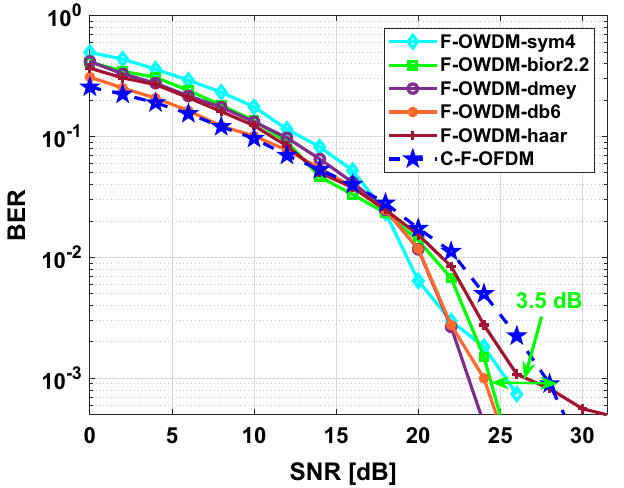
Figure 14. Comparison of BER of F-OWDM system under multipath channel for 16-QAM